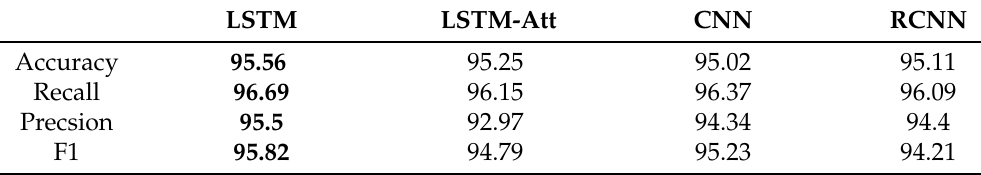
Table 1. The performance metrics of all DL methods used in PPR development.